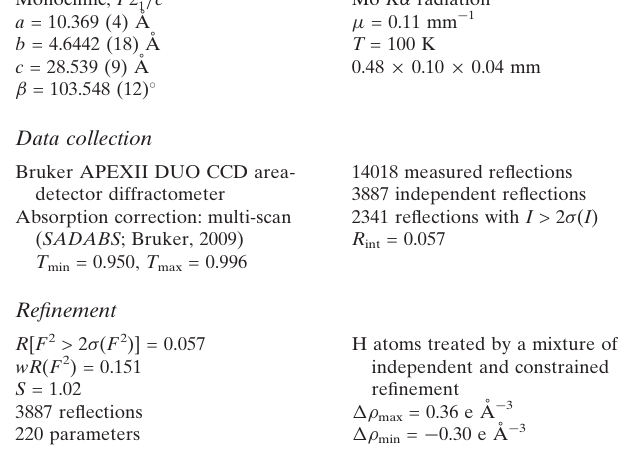
Bruker APEXII DUO CCD area- detector diffractometer Absorption correction: multi-scan ( SADABS ; Bruker, 2009)